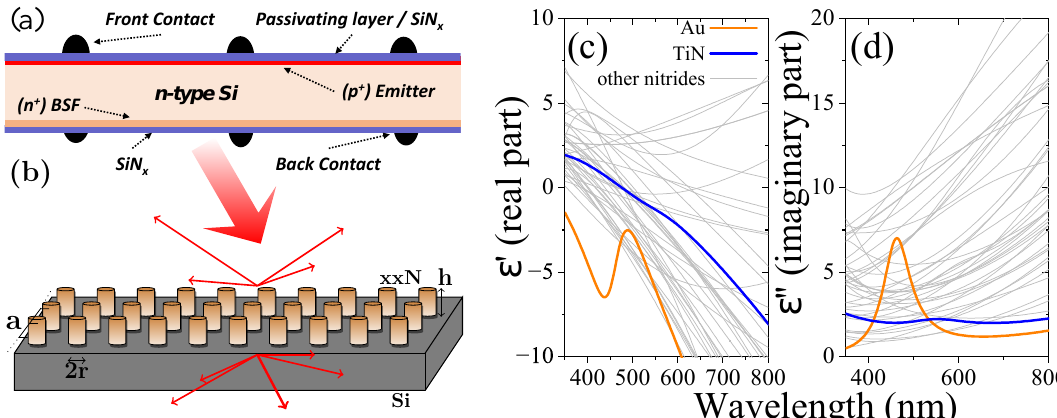
Figure 1. Illustration of the considered setup and its range. ( a ) n-PERT BiSoN cell, here with flat passivating layer as simulated. ( b ) Cylindrical pillars of height d and radius R made of nitrides and other materials for comparison standing on the n-PERT device with particle-particle separation a . The nanopillars are placed within the SiN x . Range of measured ( c ) real and ( d ) imaginary part of the permittivity of gold (orange [49]), TiN (blue [50]) and further nitride materials (grey